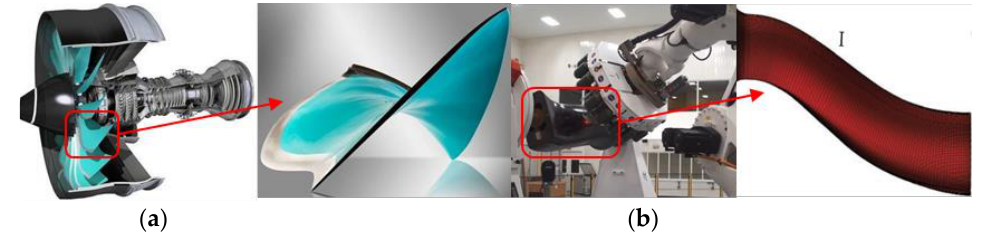
Figure 1. Schematic diagrams of ( a ) an engine blade and ( b ) an S-shaped inlet.